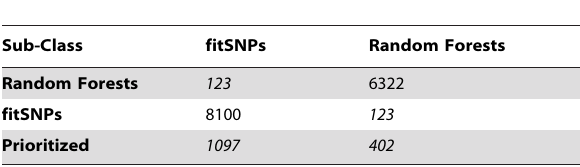
Table 2. ab initio Probe distribution by category: Categories in italics represent shared probes from those respective